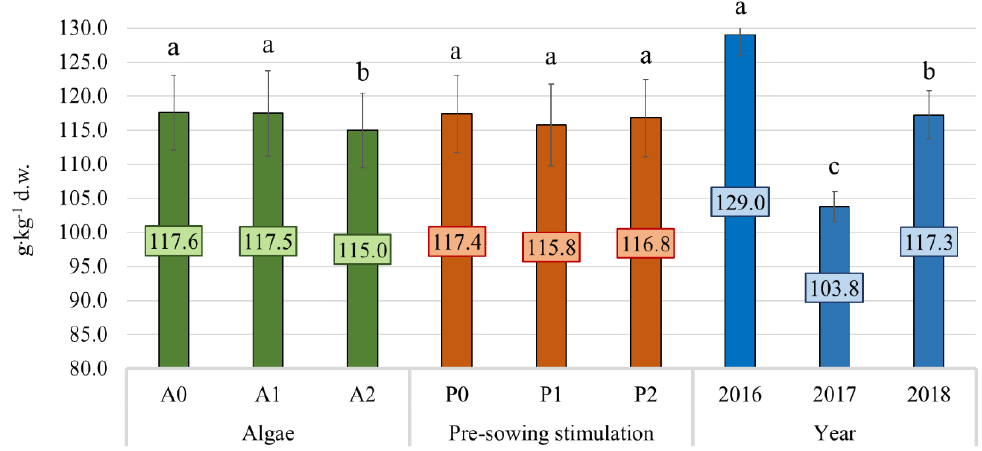
Figure 3. The mean protein content of oat grains in 2016–2018, depending on the experimental factors used. According to Tukey’s Honest Significant Difference (HSD) test, the means marked with the same letter are not significantly different at α ≤ 0.05.